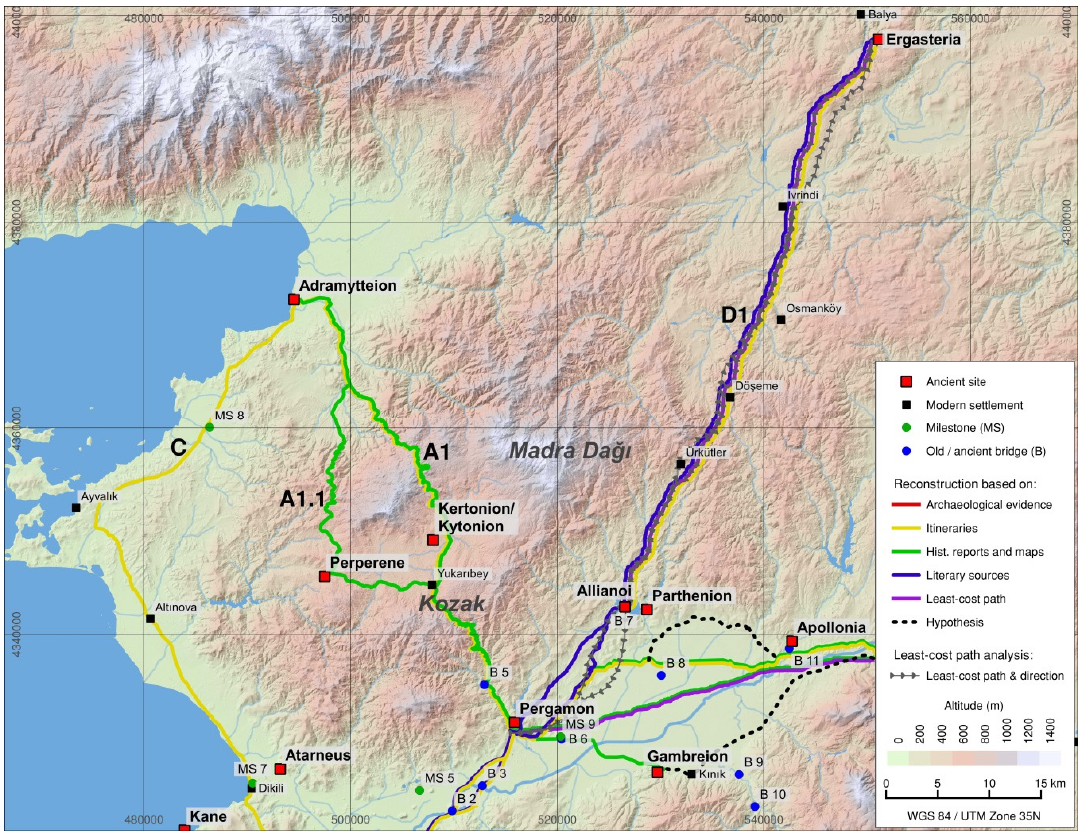
Figure 14. Calculated least-cost paths and reconstructed routes between Ergasteria and Pergamon.